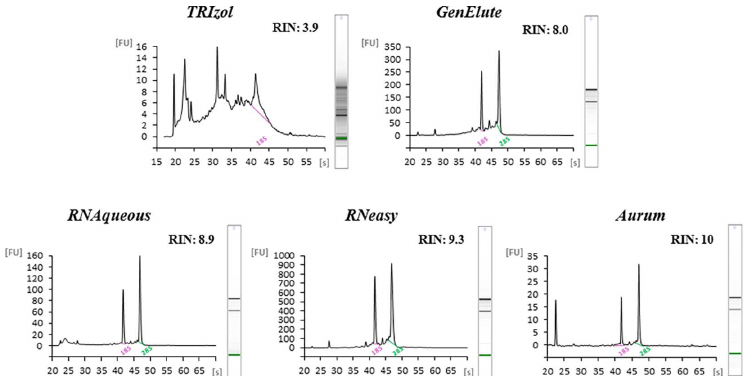
Fig 2. Agilent Bioanlyzer electropherograms. Examples of representative Agilent Bioanlyzer electropherograms of P . lividus RNA: for TRIzol, GenElute and RNAqueous RNA extraction from 5000 embryos extraction; for RNeasy and Aurum RNA extraction from 2500 embryos (see also Table 1). Relative Fluorescent Unit (FU) and seconds of migration (s) of RNA samples isolated according to the five different extraction methods are reported. RIN values are also